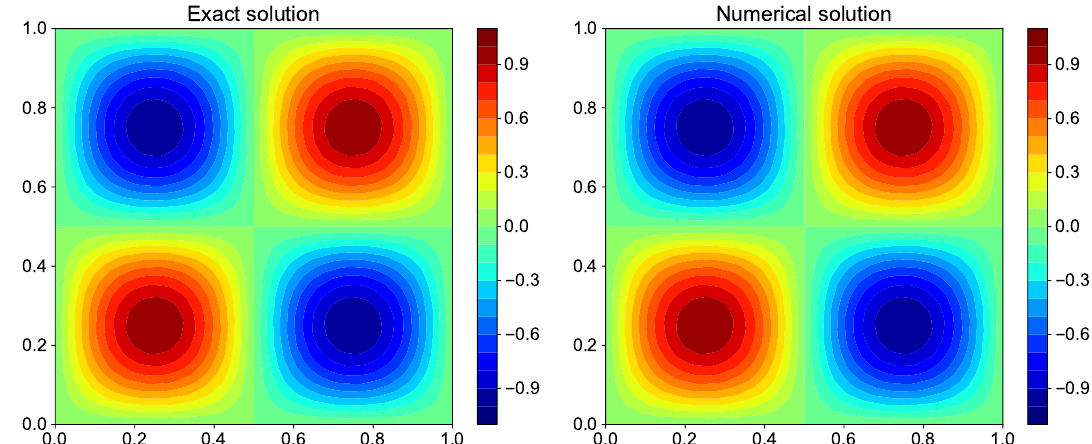
Figure 19. Comparison of exact solution and numerical solution computed using fast sine transform method for the Poisson equation with Dirichlet boundary